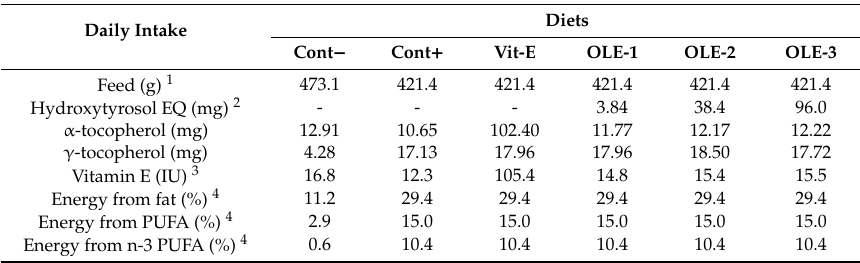
Table 2. Daily intake of feed, energy and antioxidants calculated for a 10-kg